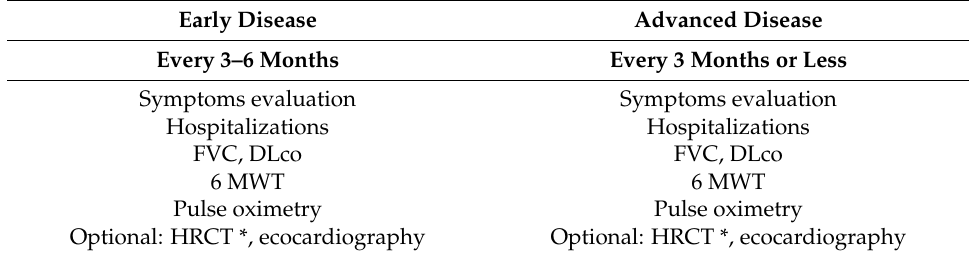
Table 7. Main examinations during follow-up